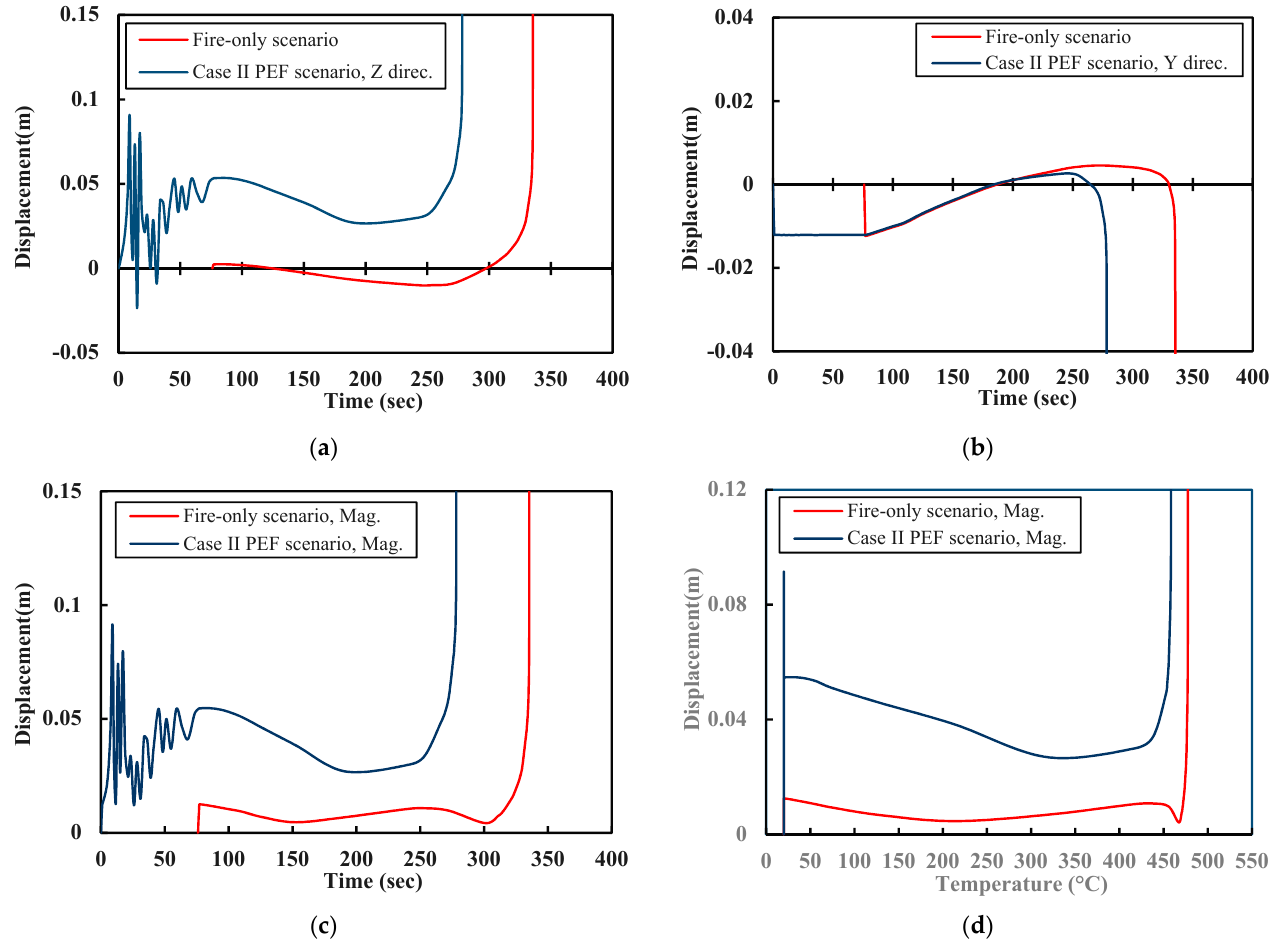
Figure 13. Comparison of the fire-only analysis versus the PEF analysis for Case II including ( a ) the time-mid-span displacement record in the z-direction, ( b ) the time-mid-span displacement in the y-direction, ( c ) the time-mid-span displacement record for the total displacement and ( d ) the temperature-mid-span displacement record for the total displacement.